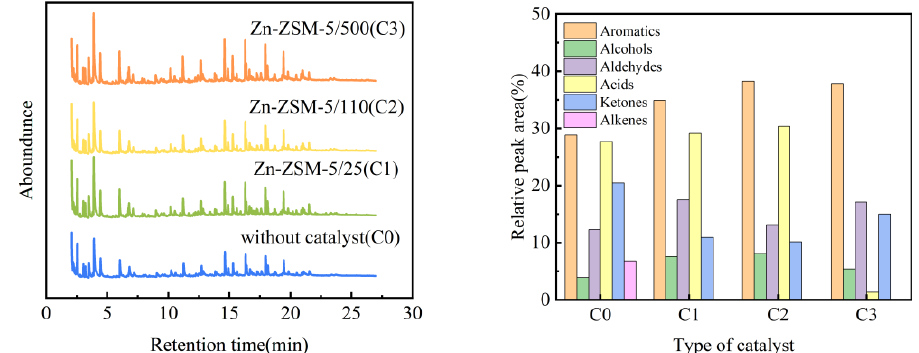
Figure 8. Total ion Chromatography (TIC) of products under different catalyst